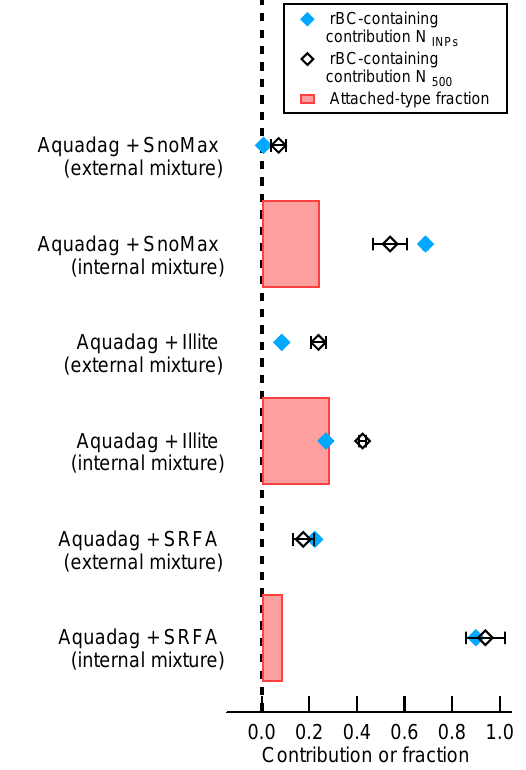
Figure 8. The rBC-containing contribution of INPs ( N INPs ) active at − 30 ◦ C and 105% RH, particles greater than 500nm ( N 500 ), and the number fraction of attached-type particles for the internally mixed scenarios. As shown, the attached-type fraction correlates poorly with rBC contributions to N INPs . The errors bars represent 1 standard deviation of the mean from at least three measurement